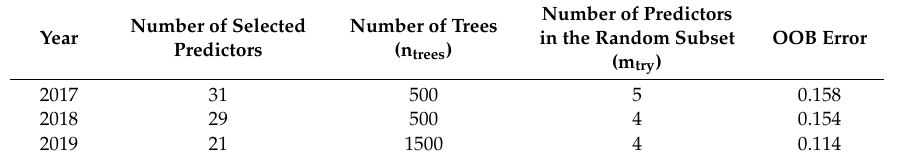
Table 3. Selected parameters for 2017, 2018, and 2019 RF classifications based on S1 and S2